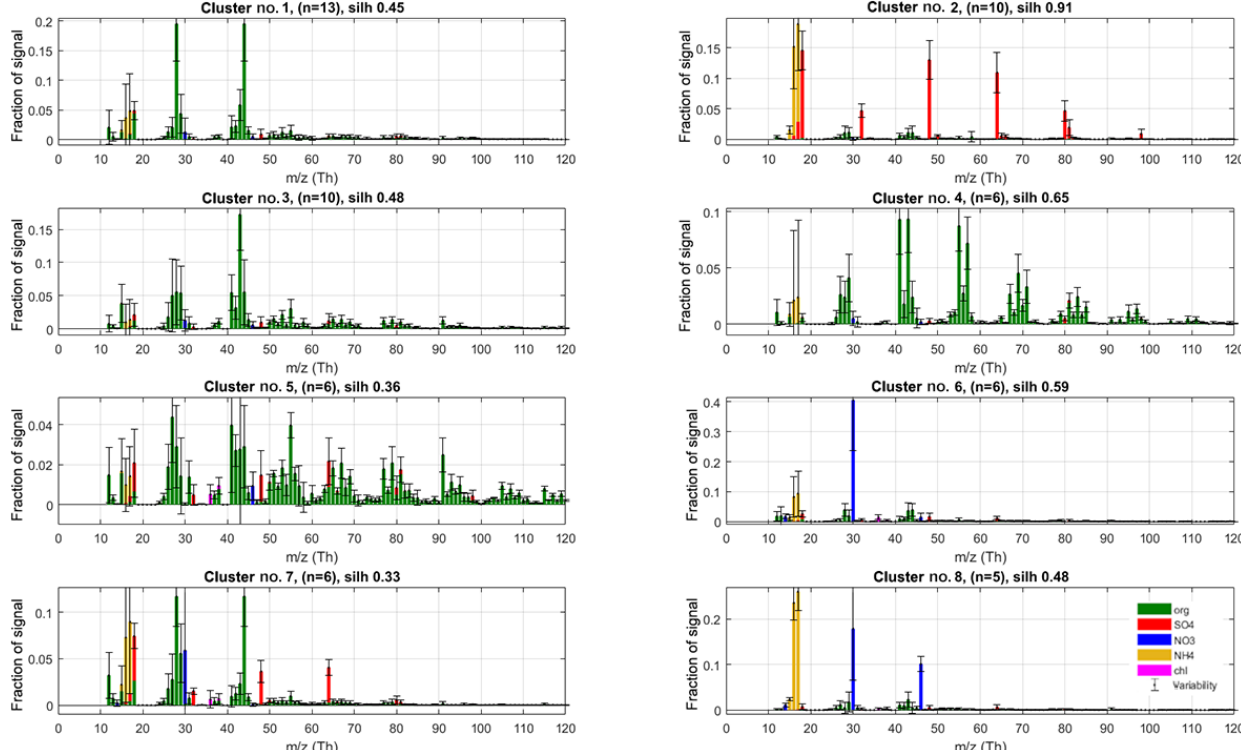
Figure 3. The eight largest clusters for P-I classification of factorisation results. Cluster centroids (coloured bars) and variabilities (error bars) are silhouette-weighted averages and standard deviations for the cluster members. The main anthropogenic aerosol types were identified as clusters no. 2 (“Ammonium sulfate”, AS), no. 4 (“Hydrocarbon-like organic aerosol”, HOA), no. 5 (“Biomass burning organic aerosol”, BBOA) and no. 8 (“Ammonium nitrate”, AN). Cluster number, silhouette and population ( n ) are shown in panel